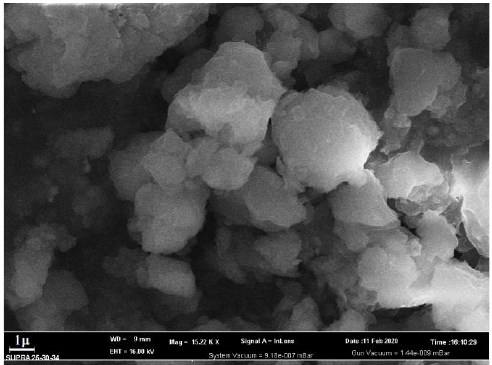
Figure 11. SEM image of cobalt terephthalate crystals after the antibiotic adsorption process.